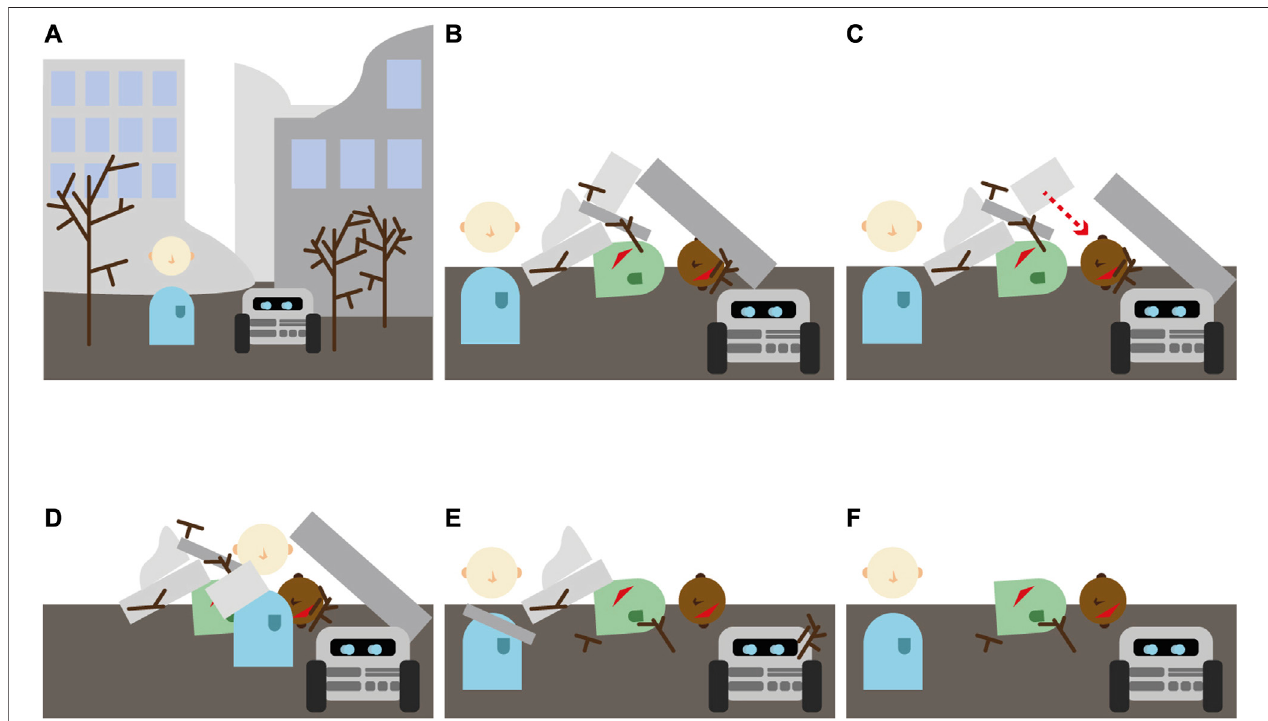
FIGURE1| Astoryboarddescribinghow ahuman-robotteam mightfreeanearthquakevictimfrom underneath apileofrocks.Inthisstoryboard,wecanseehow the robot picks up alarge rock, unaware that thiswill cause another rock tofall onthe head ofthevictim (panel C). The humannotices theissue, and steps into prevent therockfromfalling (panelD). Thiseventcanhelptherobotlearnaboutthetask,andthatitapparentlymadeamistake.Thehumancanlearnaboutthecapabilitiesofthe robot, namely that it didn ’ t understand how the rocks would fall and that it would cause harm.